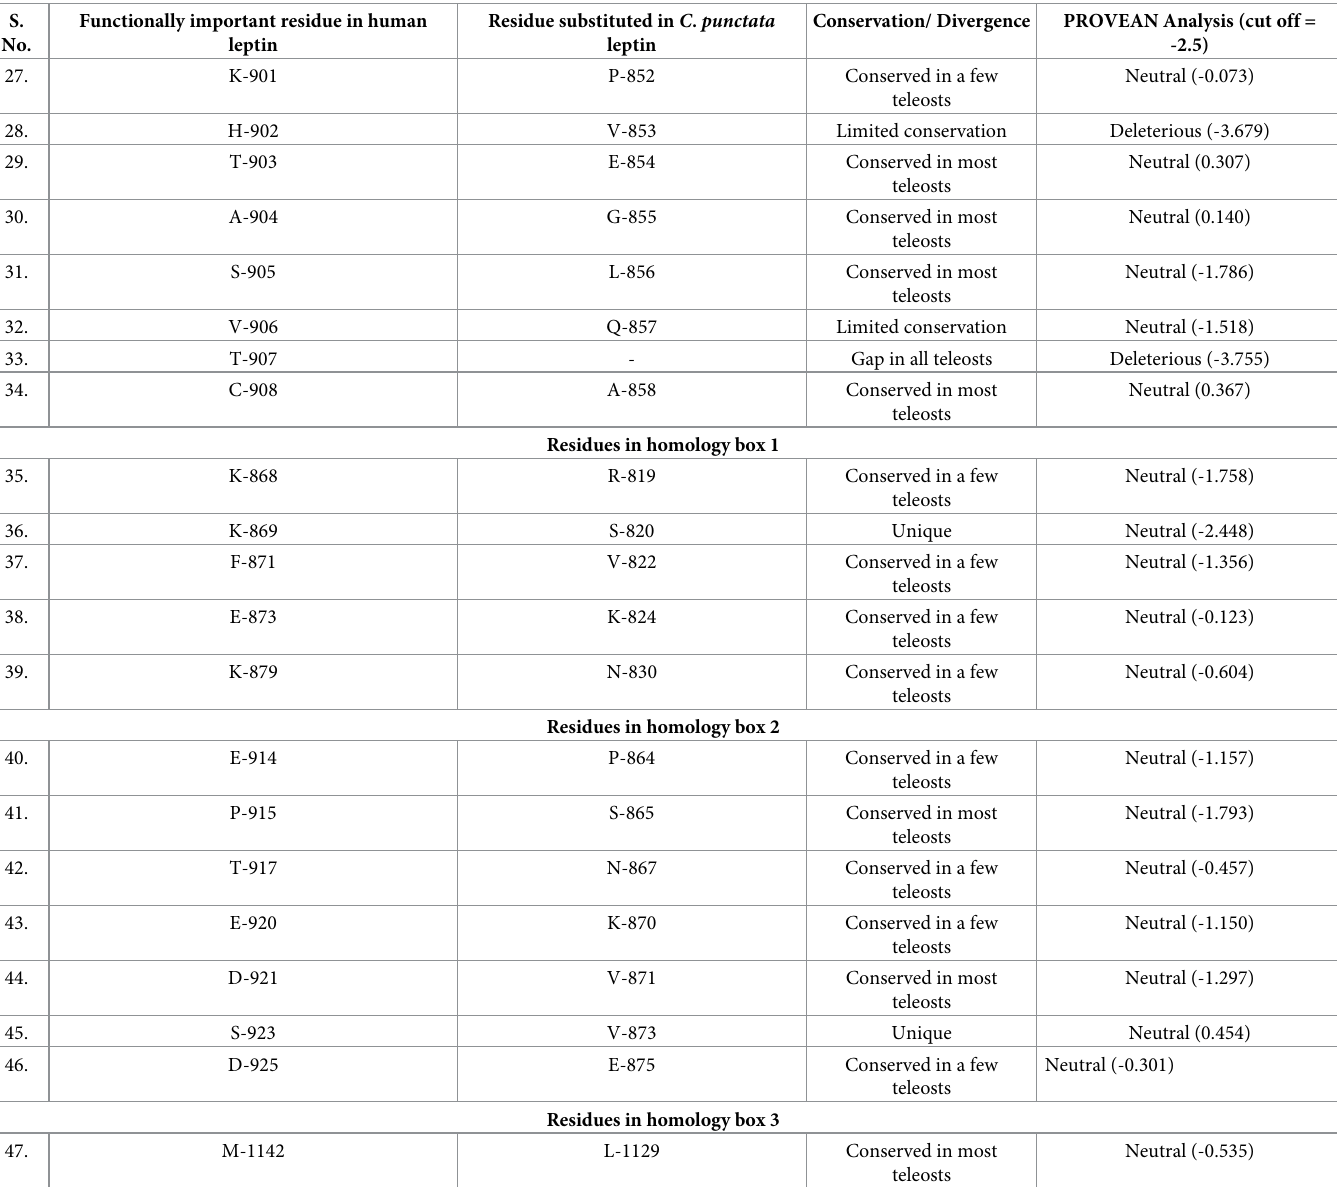
Phylogenetic analysis. The phylogenetic tree of leptin showed separate clusters for tele- osts and tetrapods (Fig 3A). Within teleostean clade, Lepa of C . punctata cladded with that of C . striata and C . argus belonging to the same order, Anabantiformes. Interestingly, lepa of elas- mobranchs ( Scyliorhinus canicula , Carcharodon carcharias ), as well as teleosts including Cypri- niformes ( C . idella , D . rerio , H . molitrix ), Characiformes ( Astyanax mexicanus ), draco ) clustered with that of tetrapods. A similar pattern of cladding was noticed with lepb .